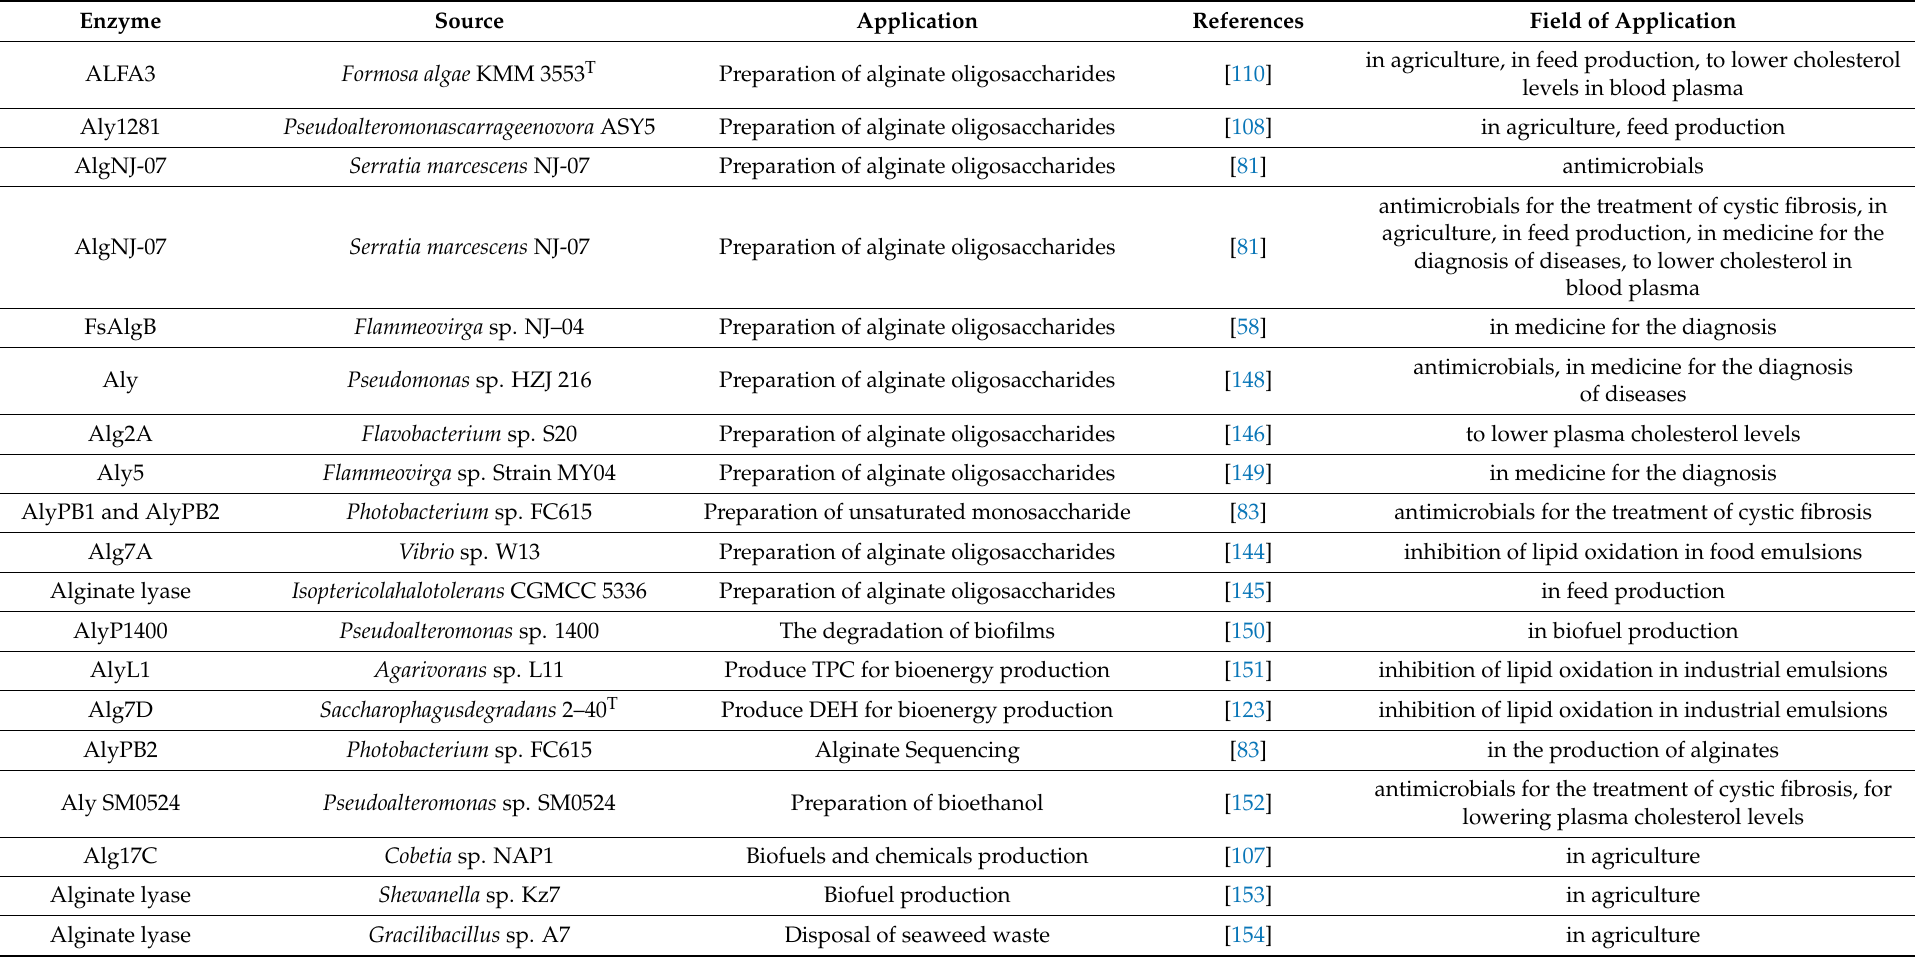
Table 4. Some applications of alginate lyase from marine